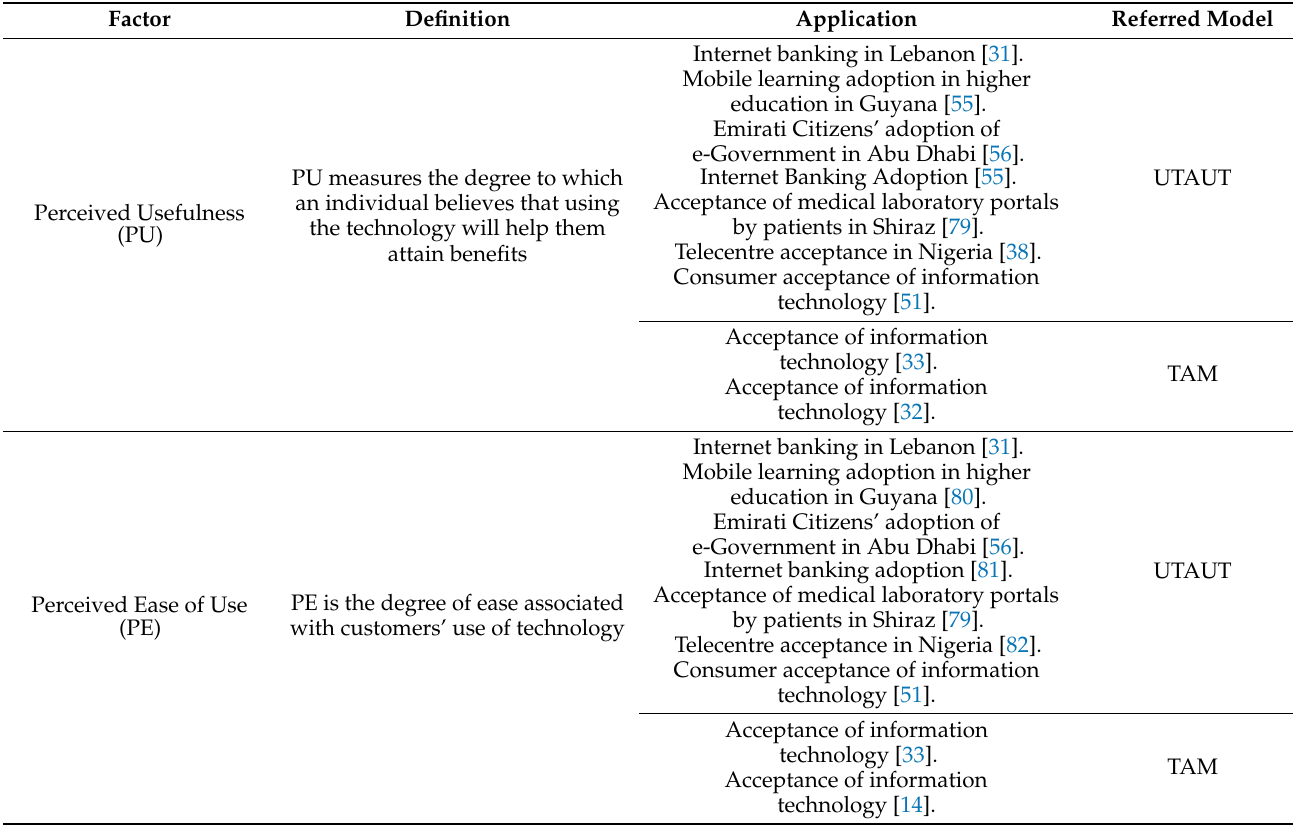
Table A1. Constraints based on literature